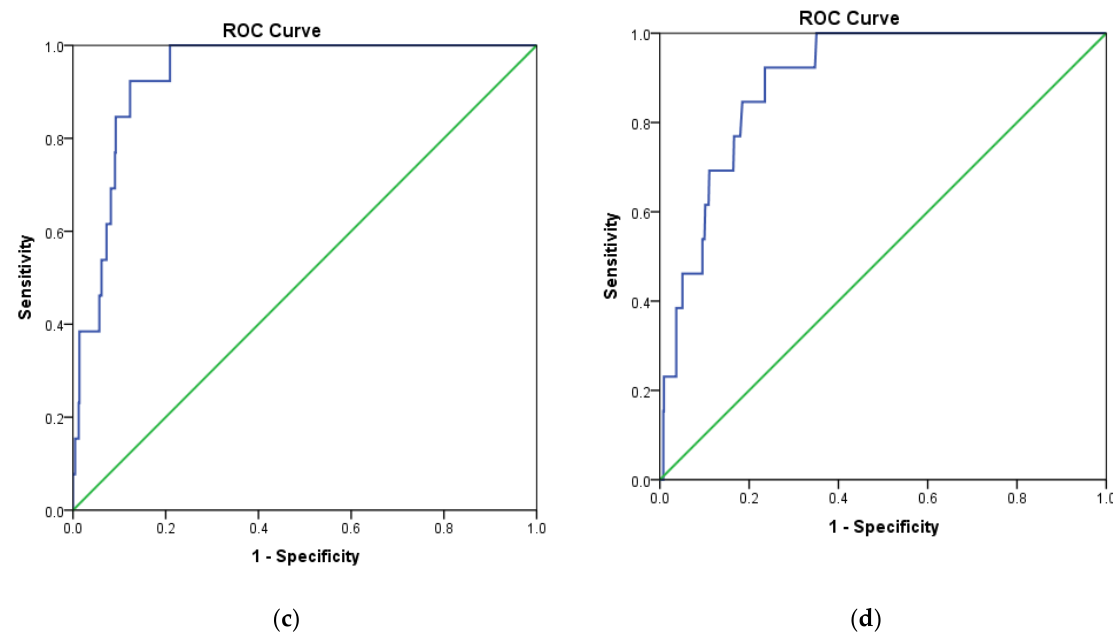
Figure 3. Receiver operating characteristic (ROC) curve validation of docking protocols using MOE2014 and Autodock4.2. ( a ) CDK4 with MOE2014, ( b ) CDK4 with Autodock4.2, ( c ) CDK6 with MOE2014, ( d ) CDK6 with Autodock4.2.